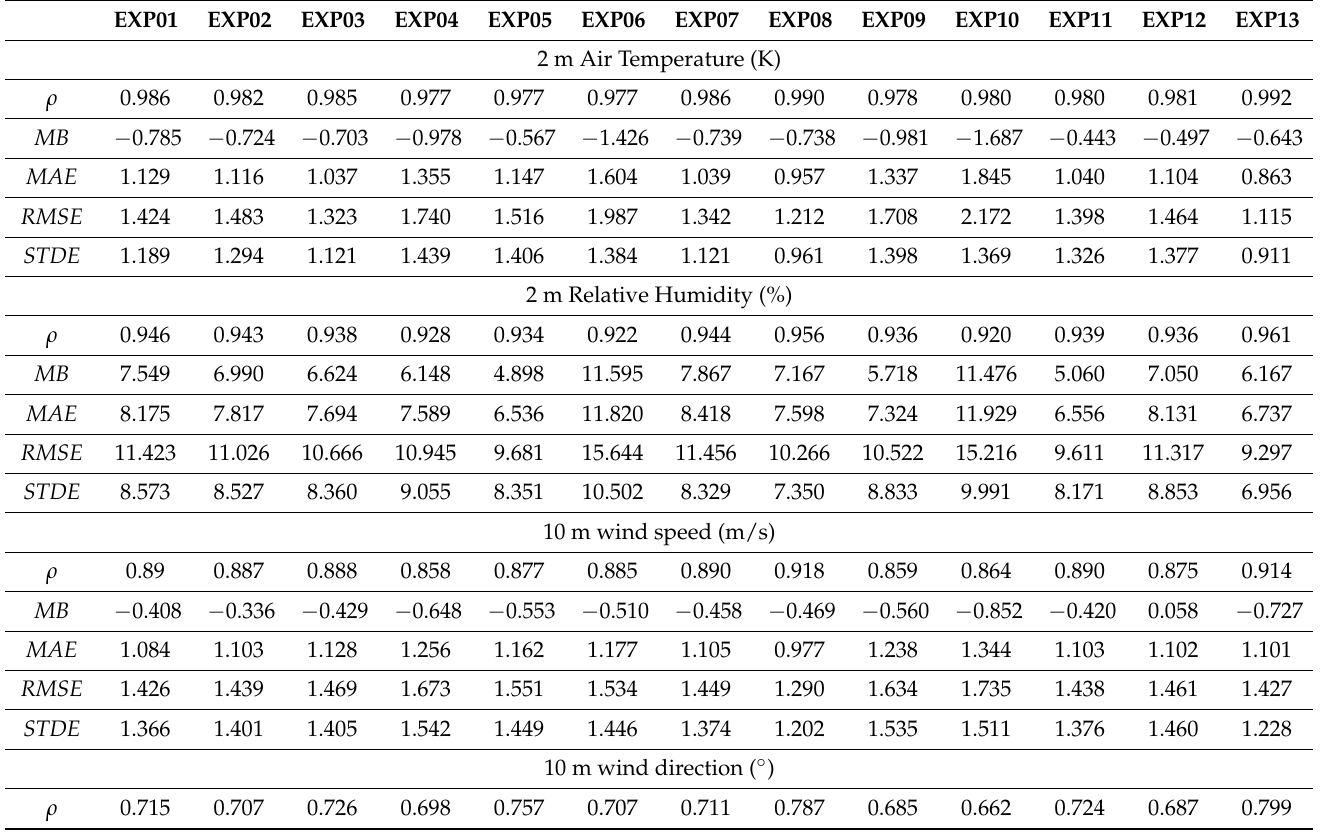
Table 6. Statistical metrics calculated for June 2019 hourly data at Aljazeera